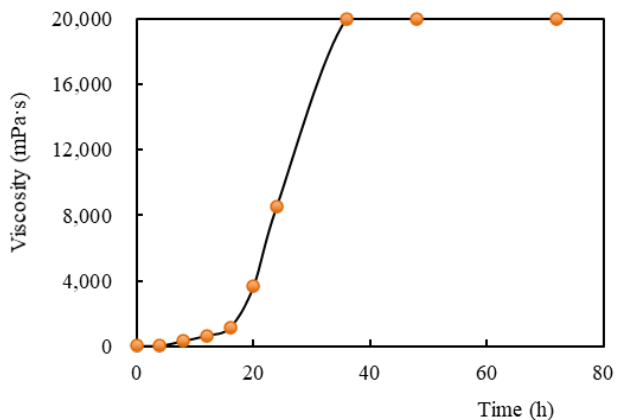
Figure 3. The relationship between viscosity and time of polymer gel.